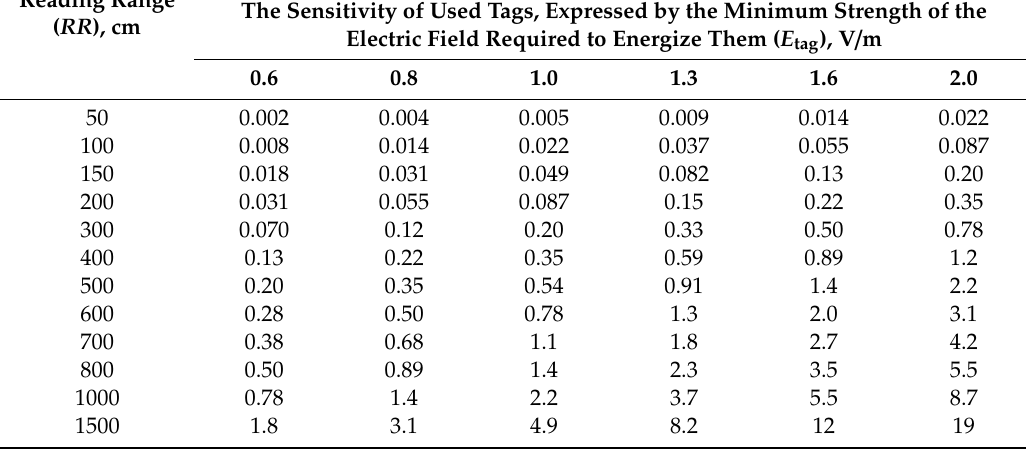
Table 4. Relation between the minimum radiated power ( P min ) and reading range (RR) of the investigated UHF RFID reader used with tags of di ff erent